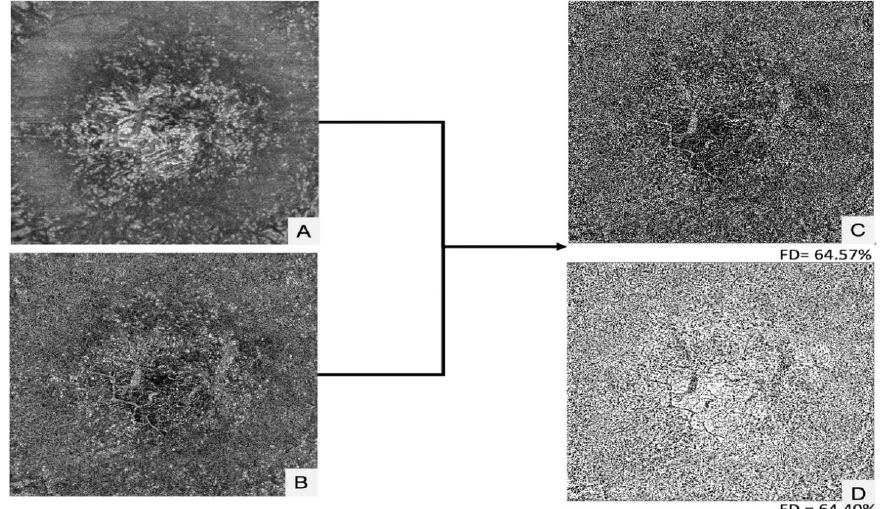
Figure 3. Choriocapillaris analysis using the Phansalkar local thresholding method in a patient’s eye with hydroxychloroquine retinal toxicity: ( A ) Choriocapillaris structure en-face image; ( B ) Choriocapillaris Flow en-face image; ( C ) Resulting image using the Phansalkar’s local thresholding method with a window radius of 4 pixels; ( D ) Resulting image using the Phansalkar’s local thresholding method with a window radius of 8 pixels .